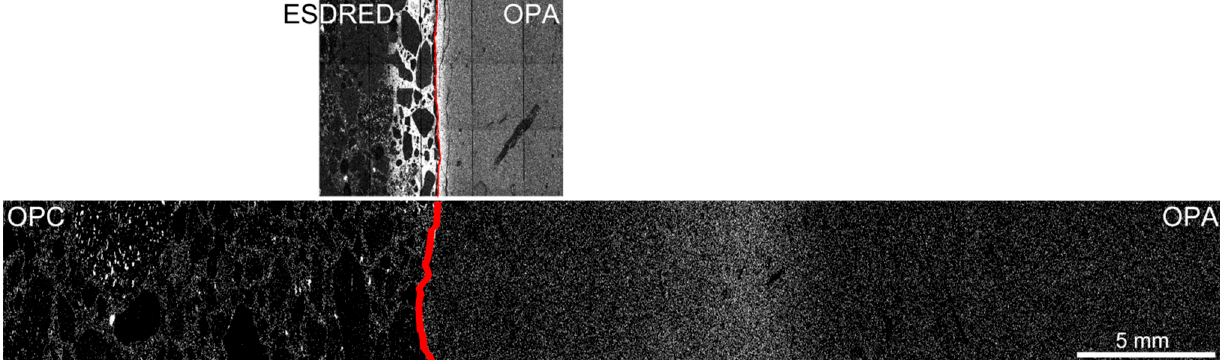
Figure 7. Comparison of SEM EDX Mg maps of interfaces (4.8 y), concrete on the left, OPA on the right of the interface marked in red. Bright areas represent high Mg concentrations. On the concrete side, only the cement matrix between the aggregates is relevant.